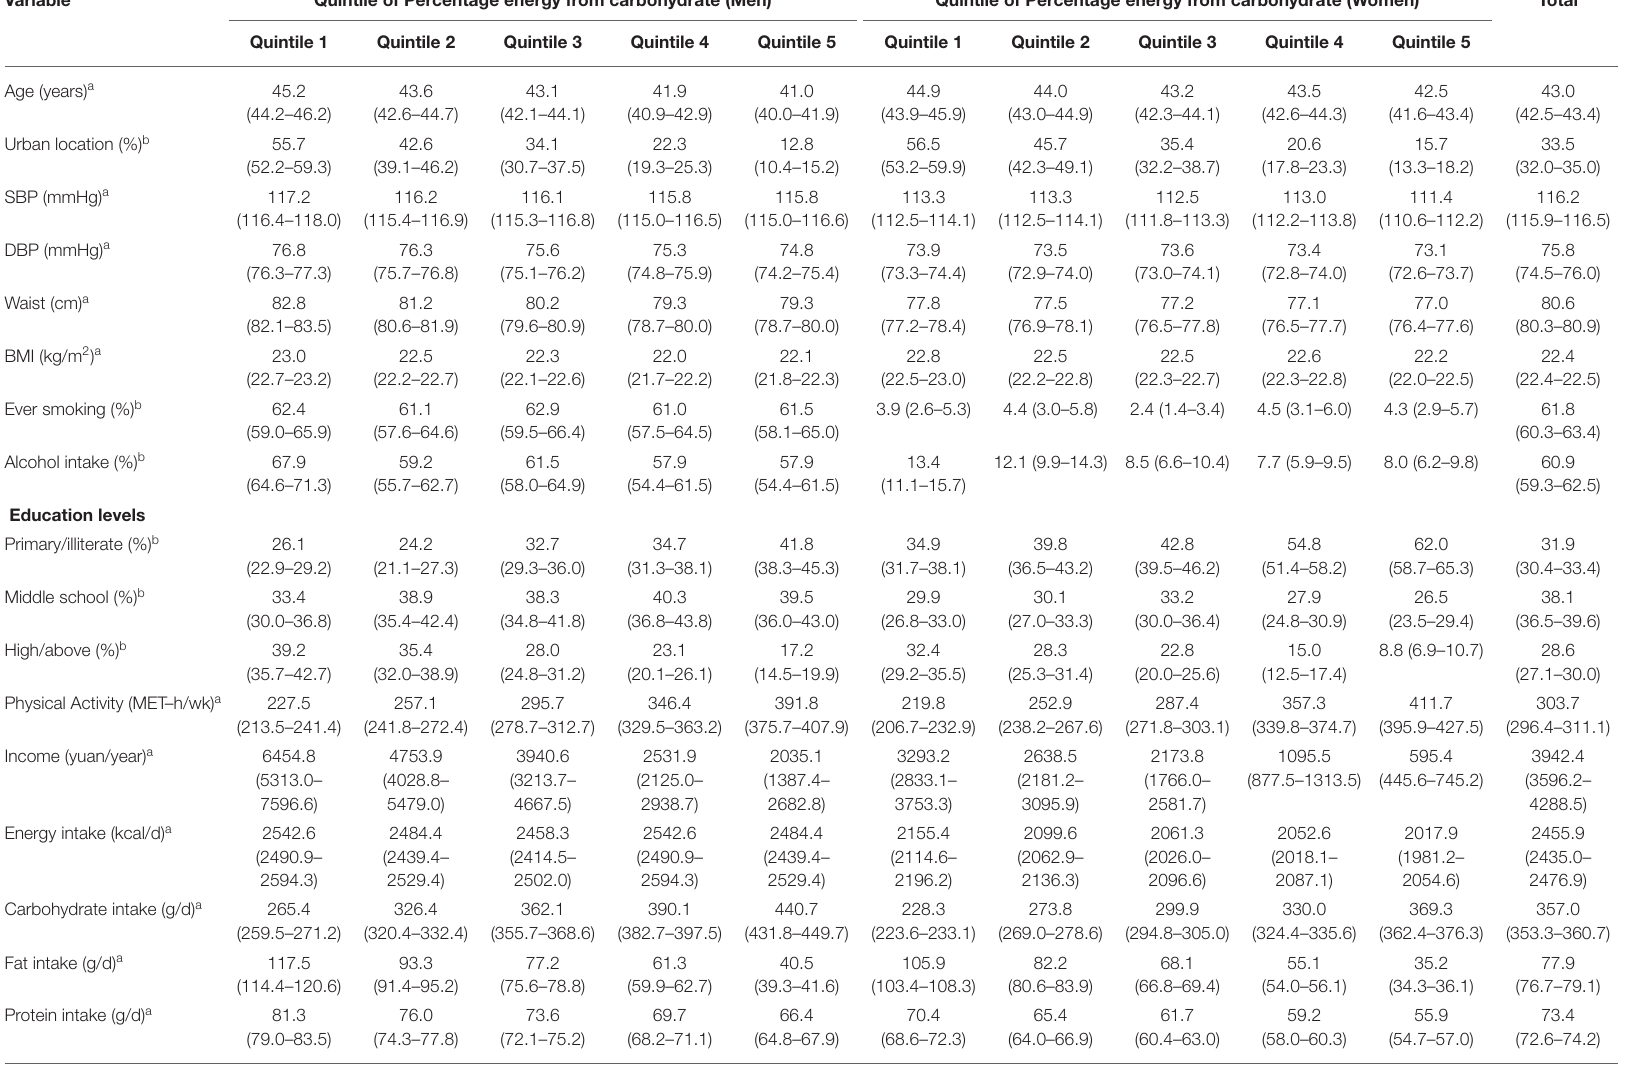
TABLE 2 | Characteristics of the study participants at the baseline among Chinese men and